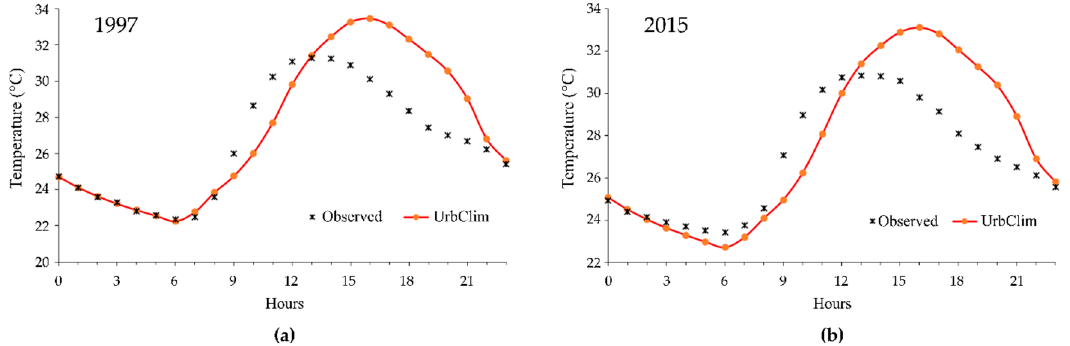
Figure 4. Mean diurnal variation of 2 m air temperature of January ( a ) 1997; ( b ) 2015.